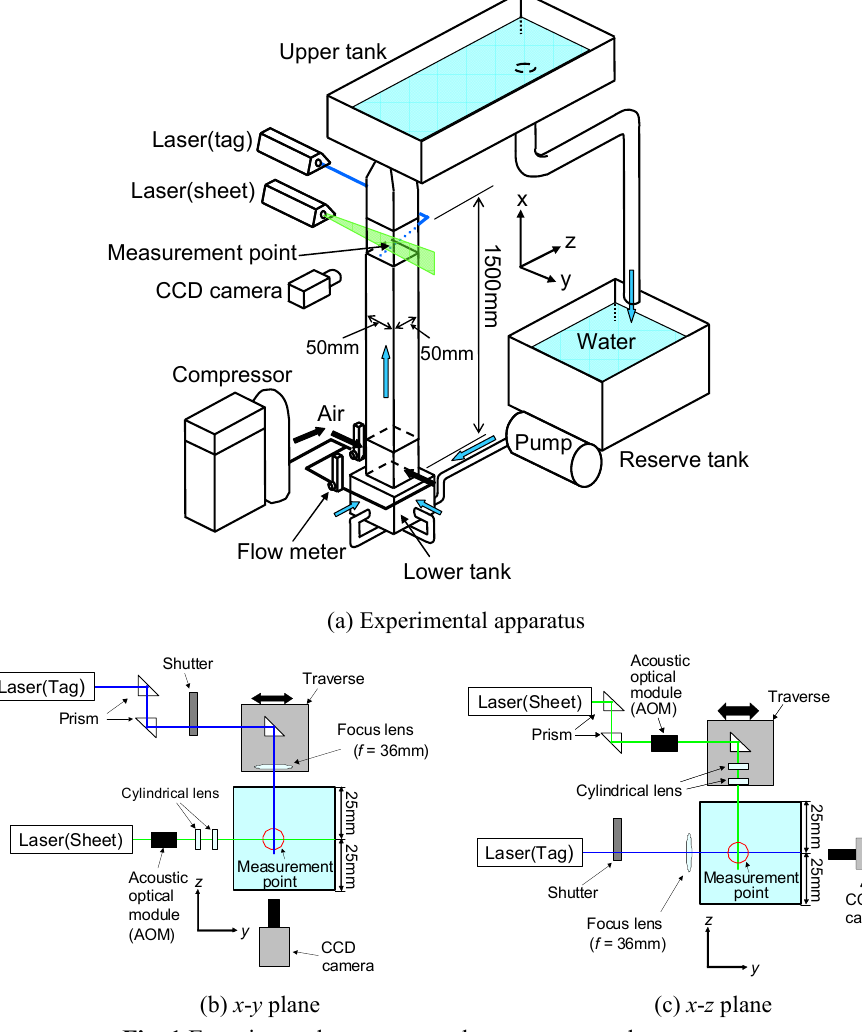
Fig. 1 Experimental apparatus and measurement